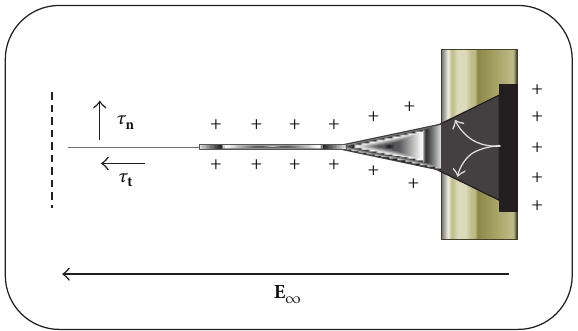
Figure 1: Taylor’s cone in the electrospinning system.